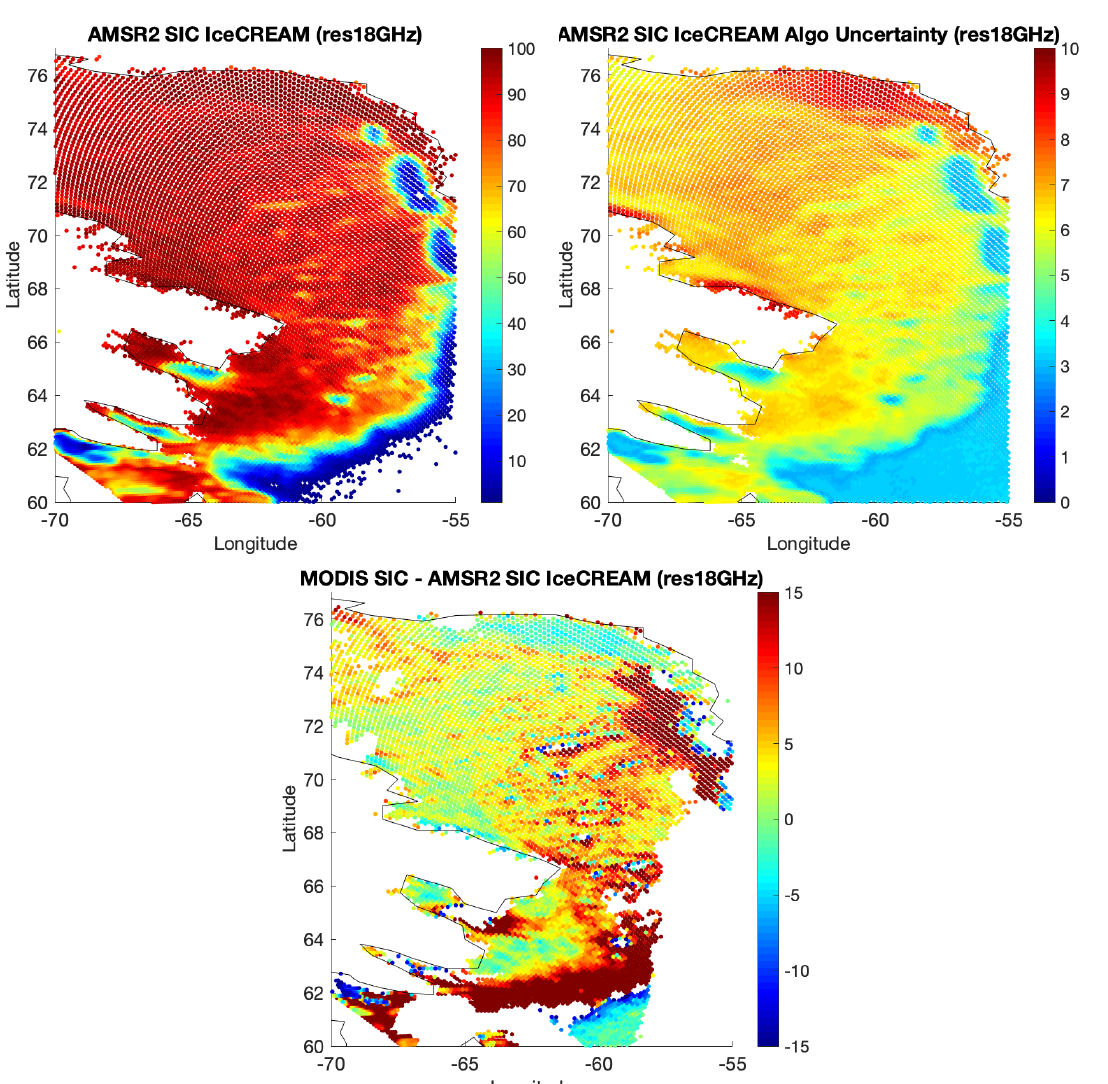
Figure 6. Top left: IceCREAM SIC retrieval results for the 20 April 2018 scene, when combining all the channels, i.e., the low (6+10GHz) and the high (18+36GHz) frequency algorithms. Top right: the corresponding theoretical retrieval error std. Bottom: Difference between the MODIS SIC and the IceCREAM SIC results. The MODIS SIC is calculated from spatial averaging over the 18 GHz AMSR2 footprint, when the cloud cover is less than 50% (leading to holes in the